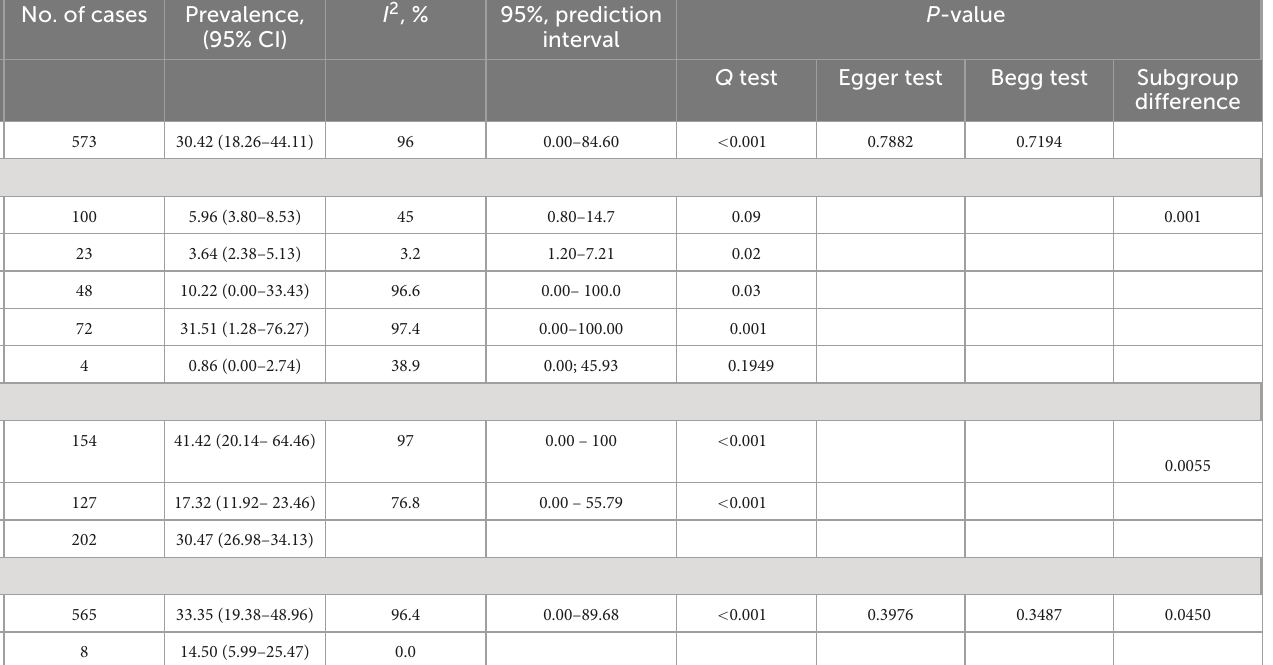
TABLE 2 Summary estimates from meta-analyses of NP disorders in patients with systemic lupus erythematosus in Pakistan.